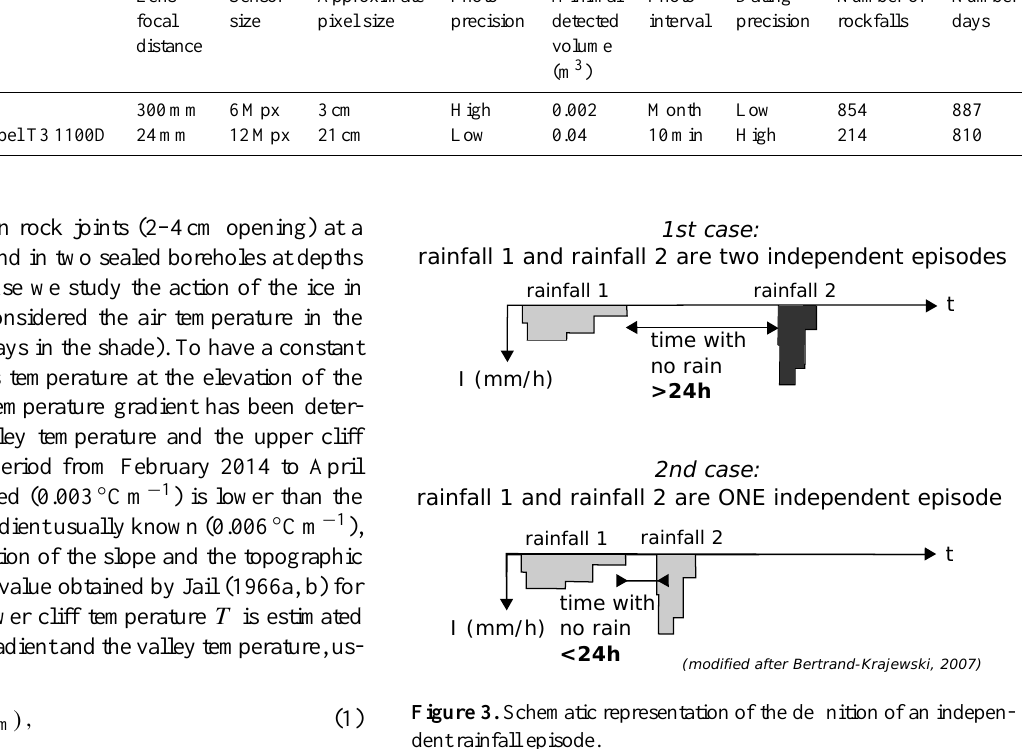
Table 3. Technical information of rockfall databases. Database